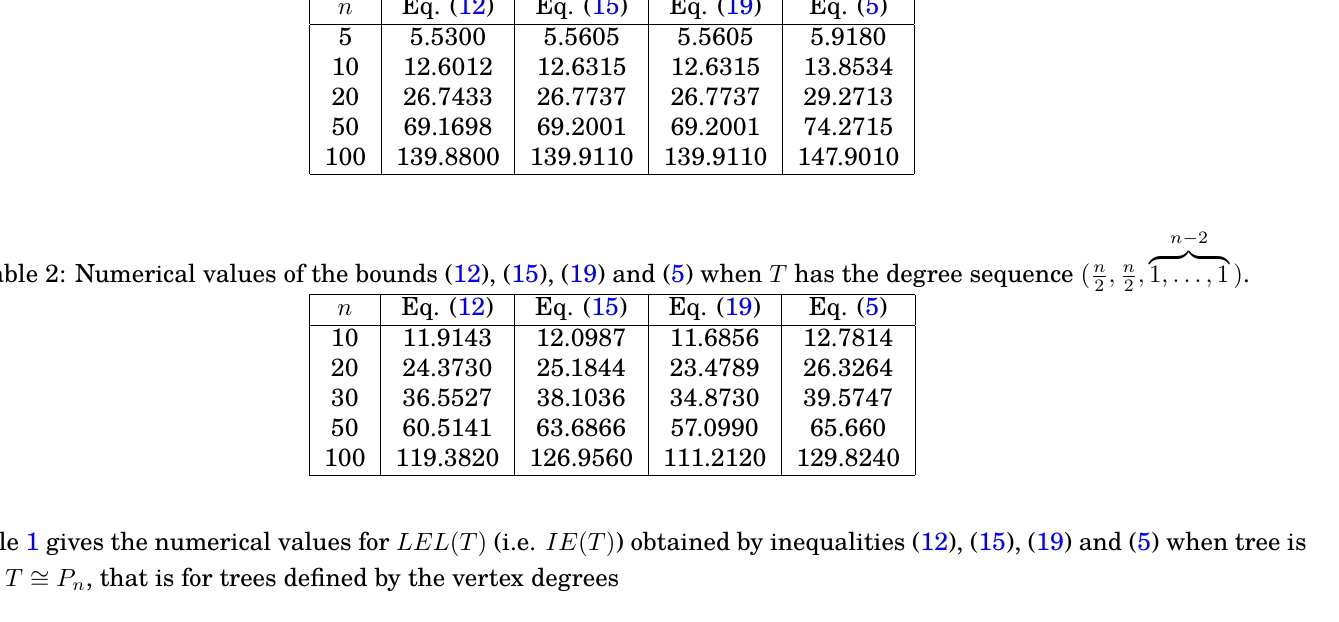
Table 1: Numerical values of the bounds (12), (15), (19) and (5) when T ∼ = P n Eq. (12) Eq. (15)